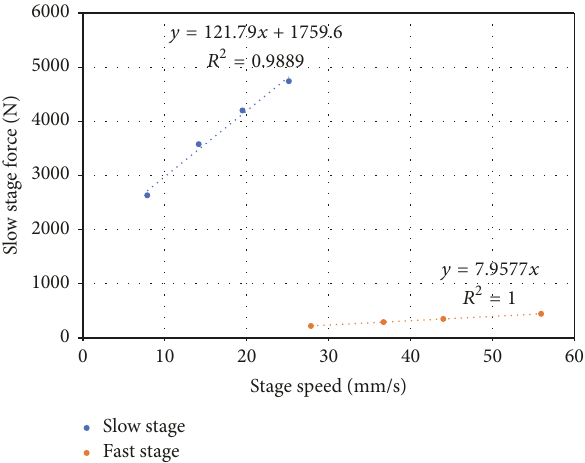
Figure 20: Force on slow and fast stages versus amplitude of speed at 1Hz and different displacement amplitudes when the fast stage of the 𝑍 -transmitter is attached to a 50 kN/m